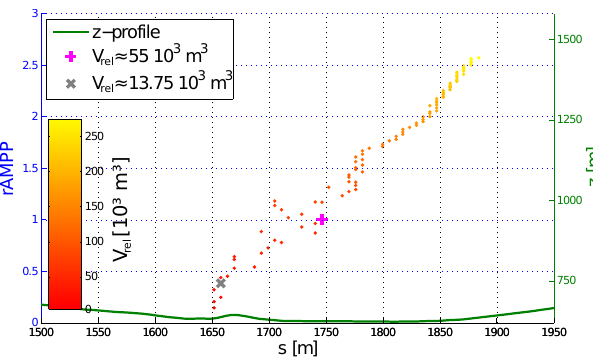
Fig. 5. Results of the AIMEC analysis, J = 100 simulation runs with continuously increasing release volume V rel . Shown is rAMPP vs run out. Reference point is the simulation run with V rel ≈ 55 × 10 3 m 3 (pink + ) release volume. Additionally the result of the sim- ulation run with V rel ≈ 13 . 75 × 10 3 m 3 (gray X) is